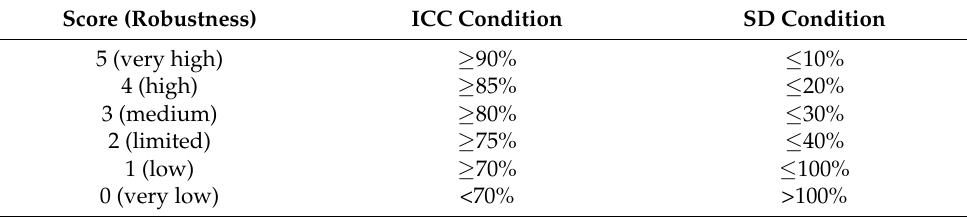
Table 2. Conditions to evaluate the robustness of each radiomic feature category. Score (Robustness) ICC Condition SD Condition